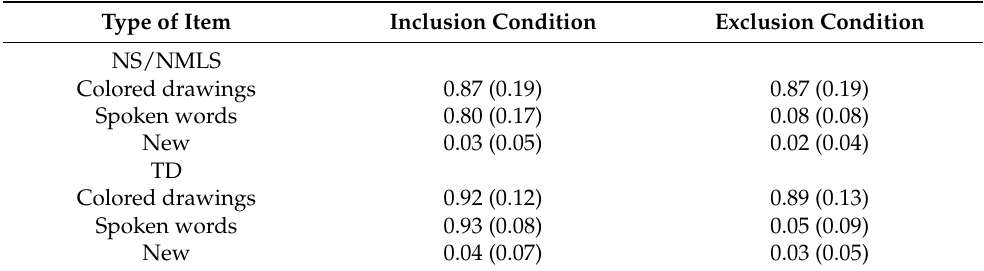
Table 2. Average (SD) proportion of “old” response to the Processing Dissociation